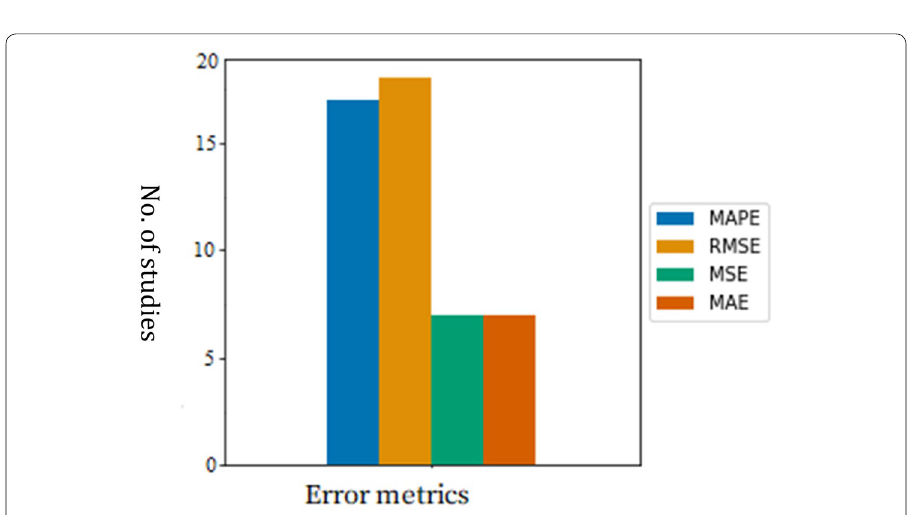
Fig. 3 Most used error metrics in electricity load